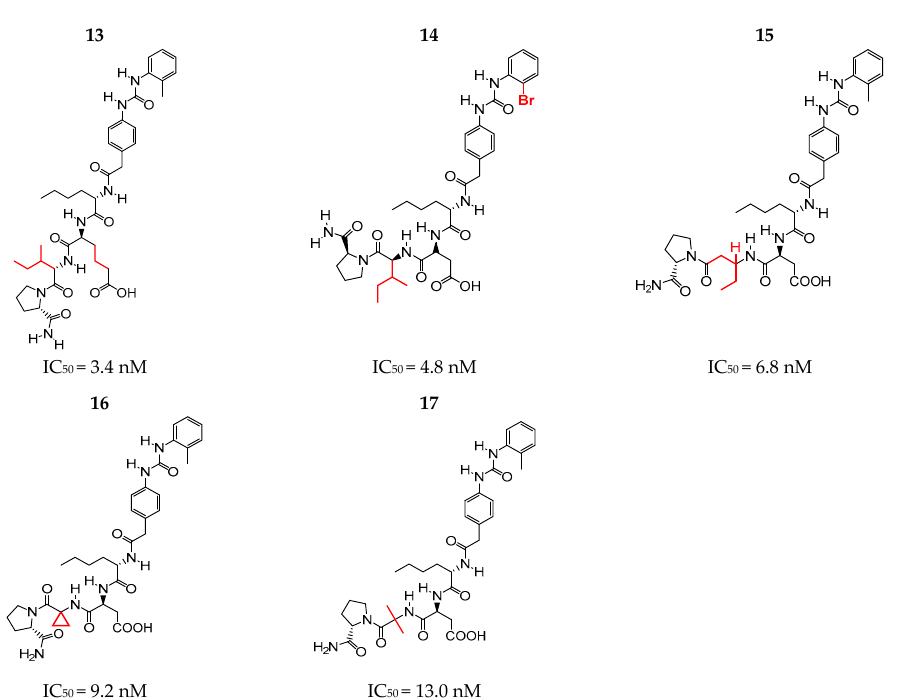
Figure 1. Structures selected (13–17) for the generation of the pharmacophoric hypotheses.